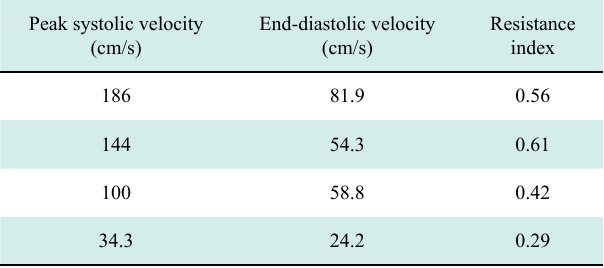
Anterior tibial